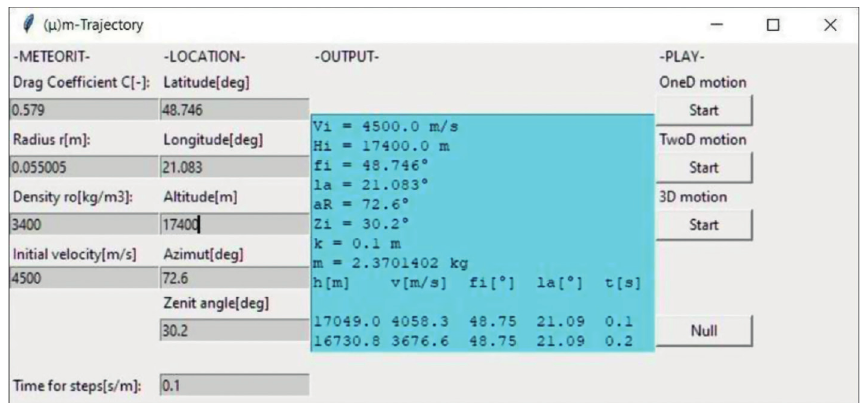
Figure 3: User interface of the μ (m)-Trajectory program with input variables and modeled values in the “output” window.